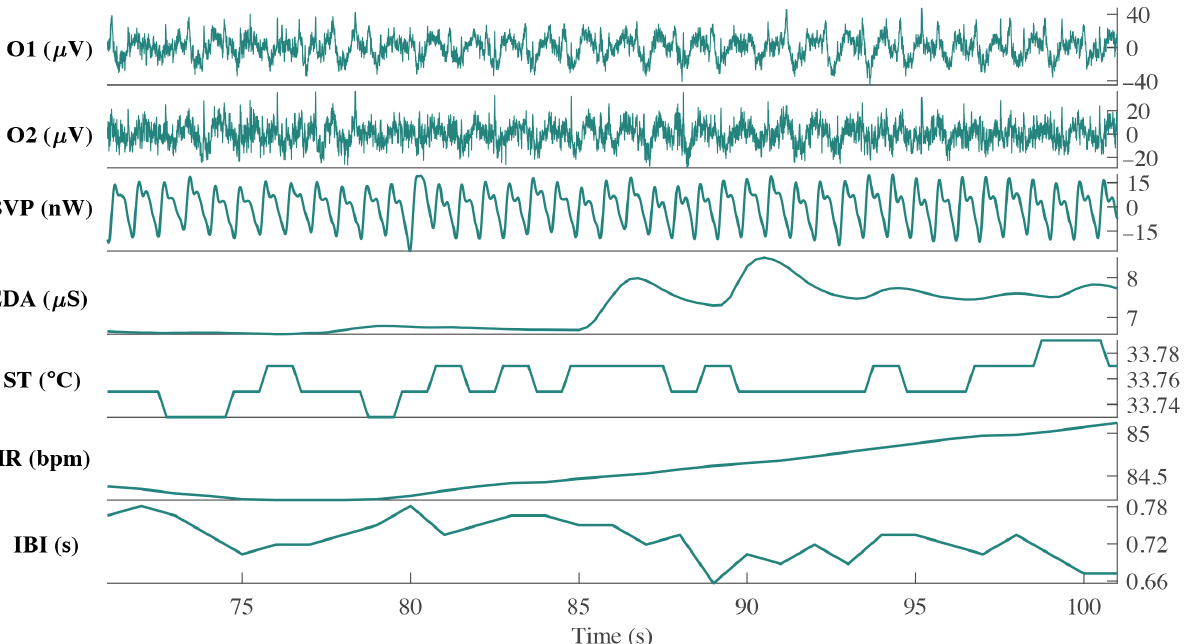
Figure 2. Thirty-second visualization of biometric signal acquisition during AO task for participant P 2 . Each row represents a different signal in the same time frame. From top to bottom: EEG (O1, O2) obtained from the OpenBCI headset, and BVP, EDA, ST, HR and IBI, obtained from the E4